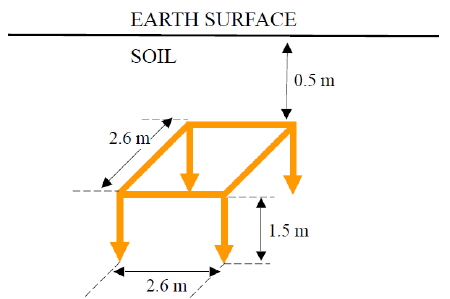
Figure 1. The complex electrode considered as a second example for validation.